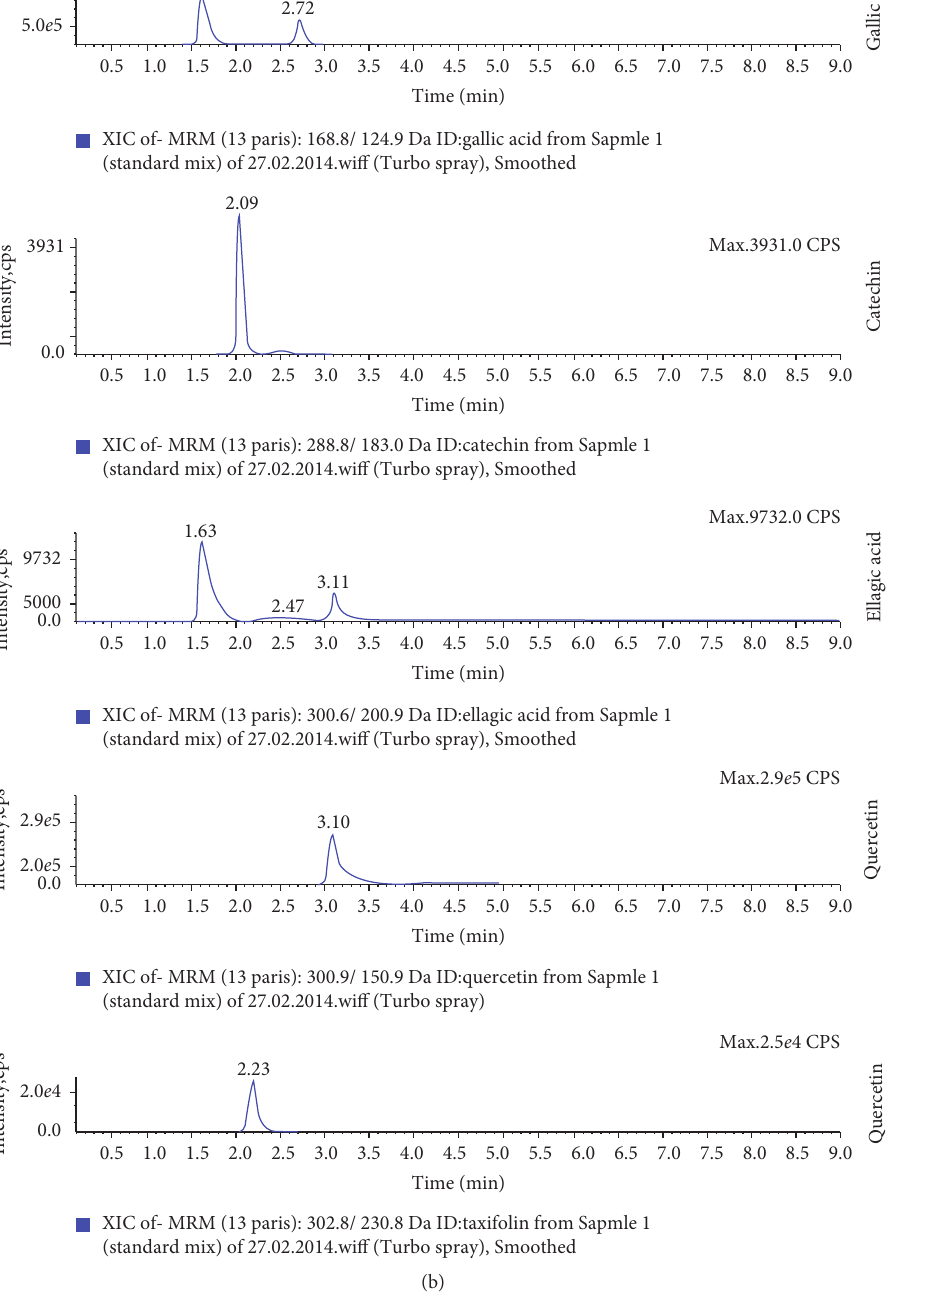
Figure 1: Standard mix of HPLC/MS-MS (optimized instrument parameters: medium-flow collision-activated dissociation (CAD) gas wiht curtain (CUR) gas: 24 psi; nebulizer gas (gas 1): 30 psi; heater gas (gas 2): 25 psi; ion spray voltage: − 4500V; source temperature: 550 ° C; compound-dependent voltage parameters for each standard are shown in Table 3. Table 3: Recorded retention times of identified compounds, where standards were available. Compound RT min Gallic acid 1.59 1.70 1.57 RT min : retention time in